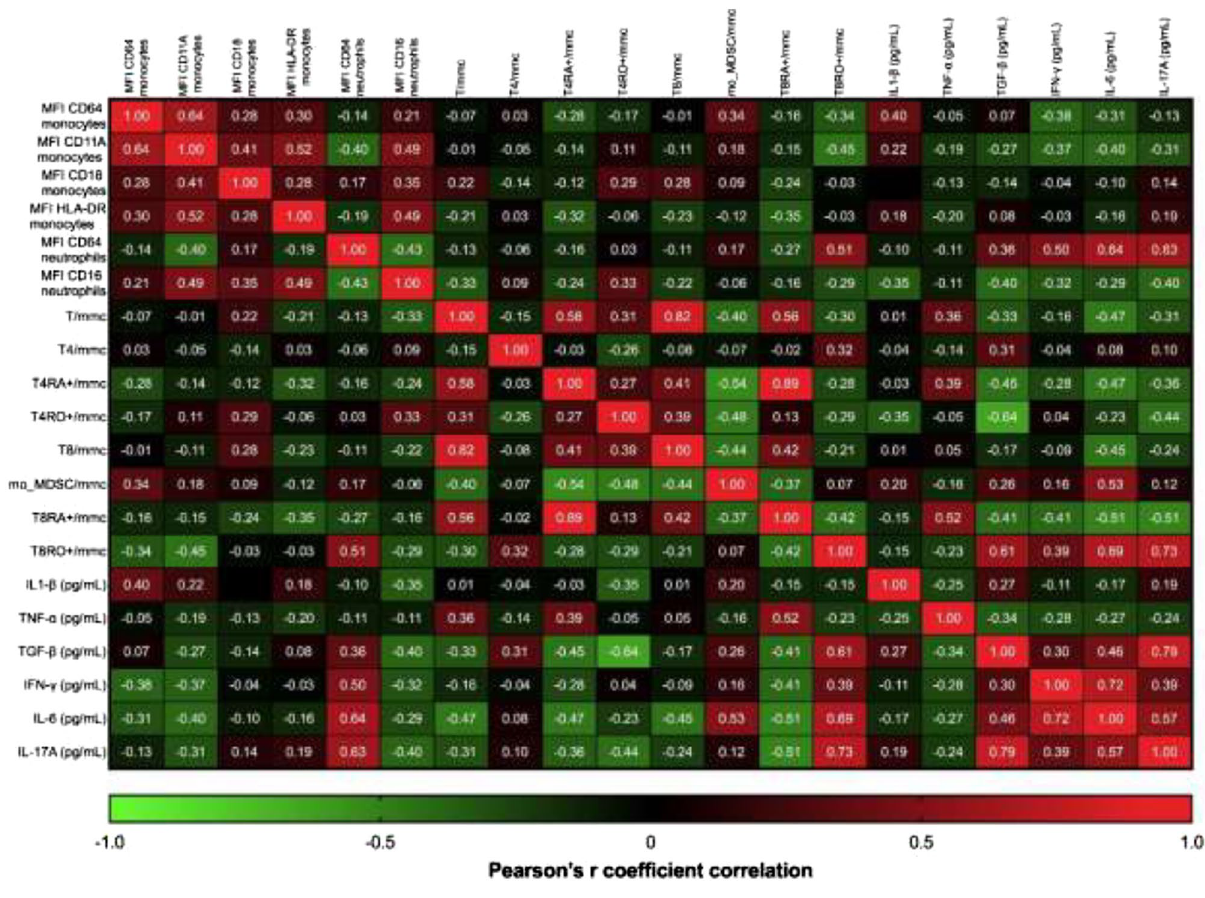
Figure 1. The correlation matrix and heatmap of Pearson’s r correlation coefficients among the multiple variables included in the analysis of COVID-19 patients. p-values of each comparison have been separately reported in Supplementary Table